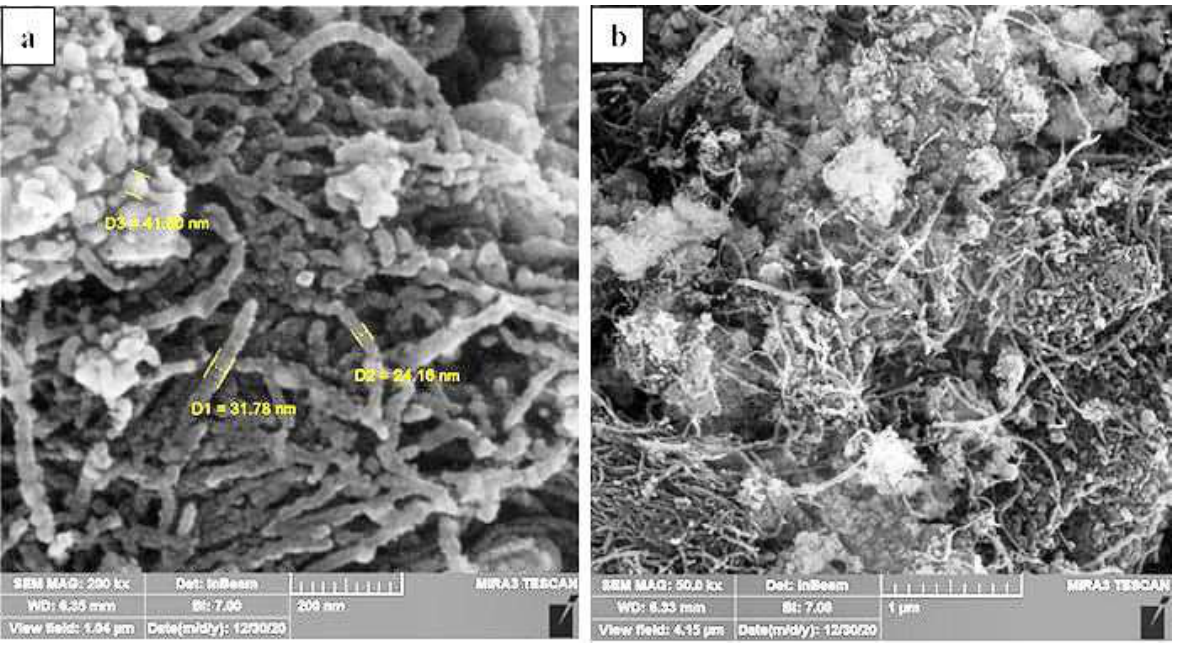
Figure 5: FESEM images of ZnO-MWCNTs hybrid with different magnifications a) at scale bar = 200 nm and b) scale bar =1